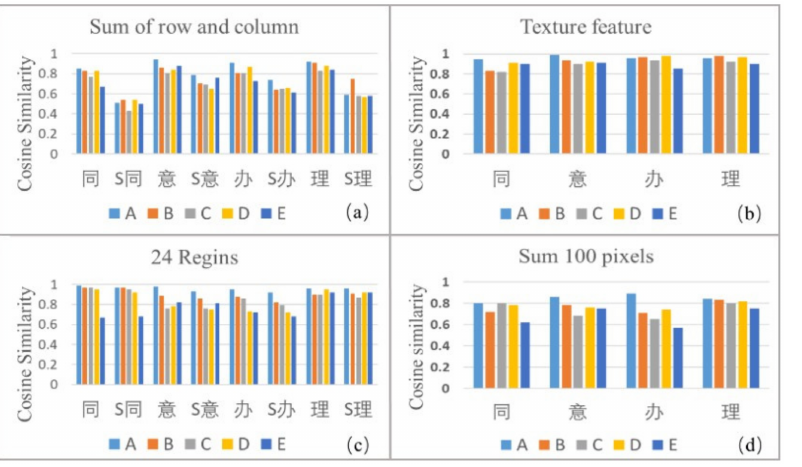
Figure 9. The cosine similarity results for the Chinese Characters “ 同 意 办 理 ” (means “agree to proceed”), where “S” means “skeleton extraction”. ( a ) Compares the cosine similarity values calcu- lated before and after skeleton extraction. ( b ) The cosine similarity values calculated based on the texture feature. ( c ) Processing Chinese character images using the 24-regins way. ( d ) Calculating the eigenvectors using the way that sum 100